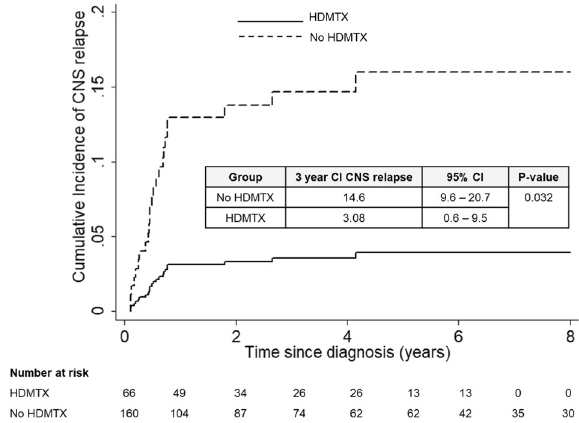
Fig. 1 Cumulative incidence of isolated CNS relapse. Cumulative incidence of isolated CNS relapse in the overall population. HDMTX, high dose